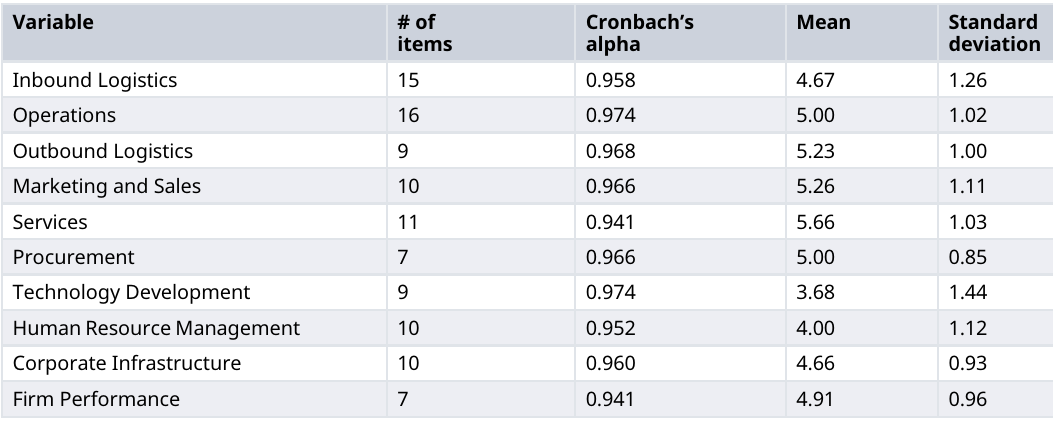
Table 2. The validity, reliability and mean